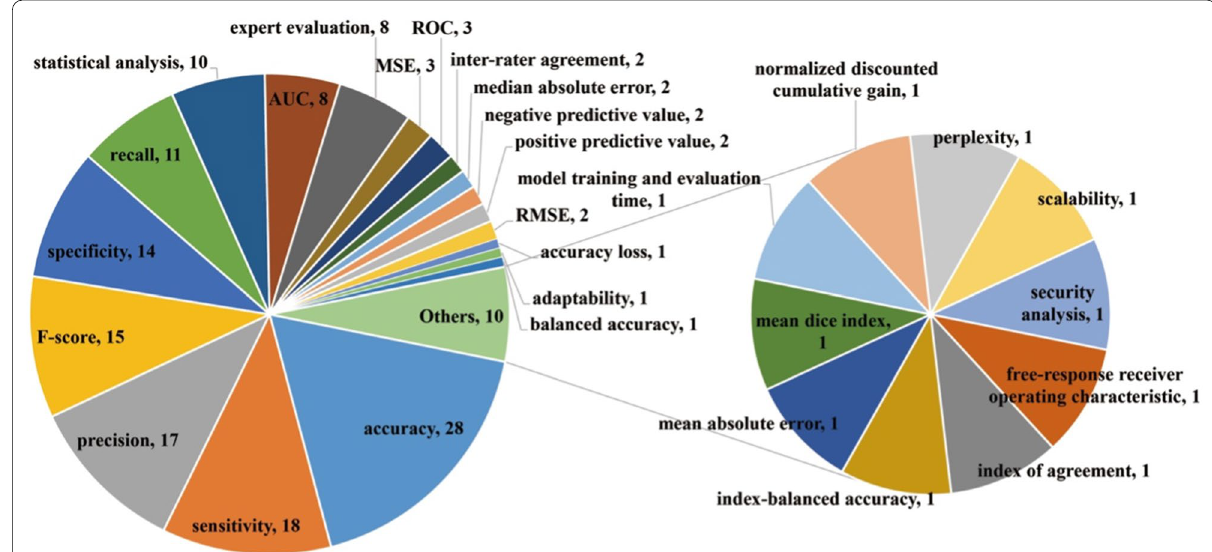
Fig. 14 Distribution of performance evaluation